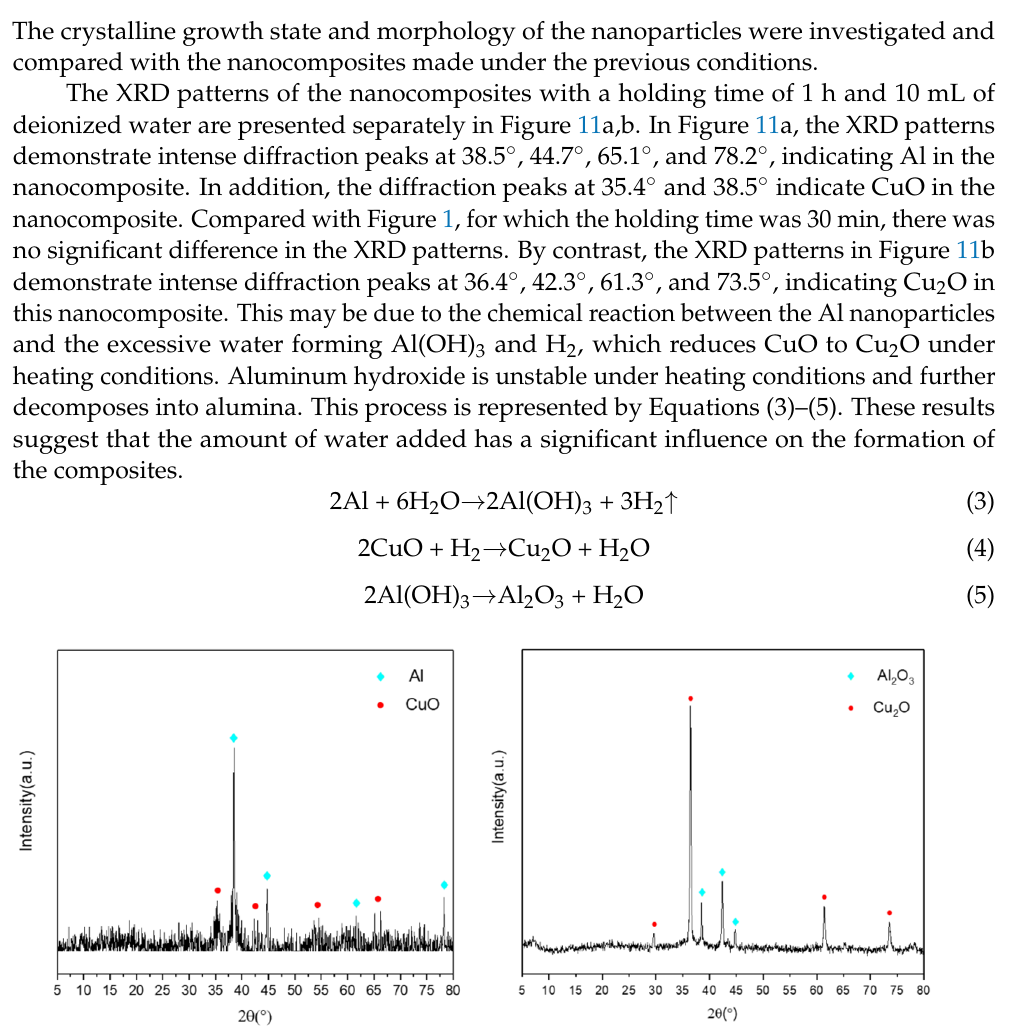
Figure 12. SEM images for ( a ) a holding time of 1 h and ( b ) 10 mL of deionized water. The crystallinity, grain size, and pattern of the sample were further inspected using TEM. The TEM images of the nanocomposite with a holding time of 1 h and 10 mL of deionized water are displayed in Figure 13. It can be observed clearly that the particles are no longer regular circles (Figure 13b), which is due to the reaction between part of the Al and the excessive water. Moreover, the particle size of the nanocomposites in Figure 7a can be estimated to be on the microscale, with particle sizes of approximately 0.6 μ m to 1.5 μ m. This means that an increase in holding time will increase the diameter of the inert particles.